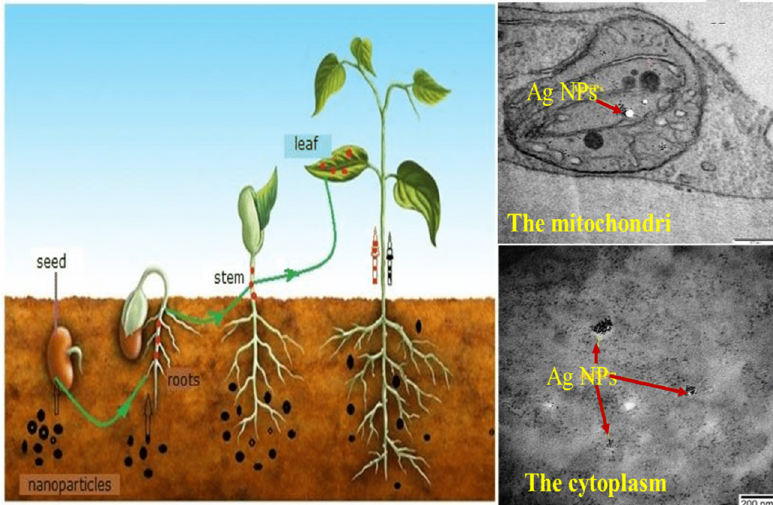
Figure 7: Migration paths of nanomaterials ( e.g. , silver nanoparticles; AgNPs ) from soil to the plant organs and the corresponding TEM images of AgNPs in the mitochondria ( leaf cells ) and the cytoplasm ( stem cell ) of wormwood ( Artemisia absinthium ) [ 113 ]